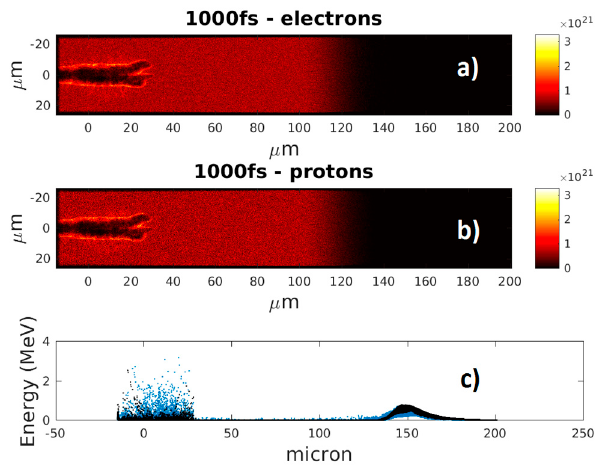
Figure 3. Snapshot of the 2D PIC after 1000 fs from the pulse entry in the simulation box of a pure hydrogen plasma at a flat density 7 × 10 20 e − / cm 3 . The electrons’ (frame a ) and protons’ (frame b ) density distributions are shown for both cases, together with the protons’ (black) and electrons’ (blue) energies versus the laser propagation direction (frame c ).